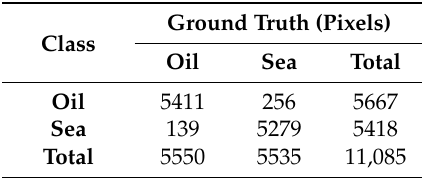
Table 5. Confusion matrix achieved by ML based on 4 fully polarimetric features.